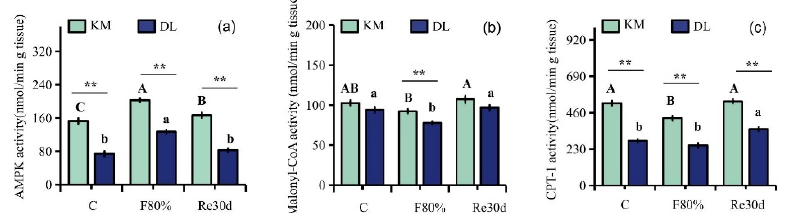
Figure 4. Activity diagram of AMPK ( a ), malonyl CoA ( b ), and CPT-1 ( c ) in E. miletus under food restriction. Different letters denote significant differences among treatments in the same region, capital letters refer to the Kunming region, and lowercase letters refer to the Dali region. ** p < 0.01 Kunming versus Dali on the same day.